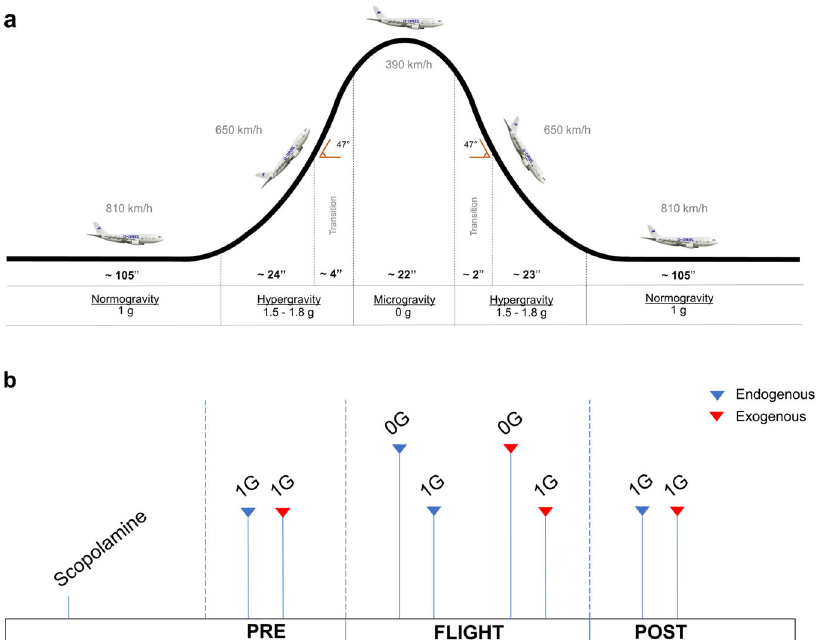
Fig. 1 Overview of our parabolic fl ight experiment. Flight trajectory during the parabolic manoeuvre ( a ) and study timeline ( b